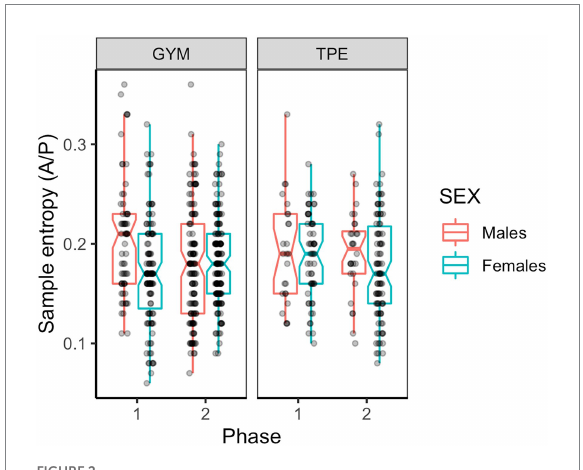
FIGURE 4 COP sway area for males and females in the GYM and TPE groups.